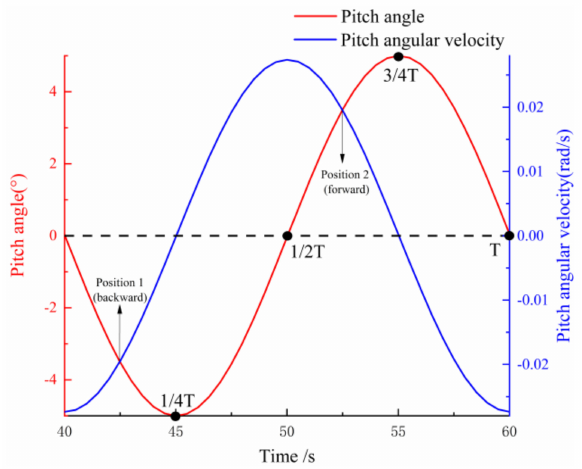
Figure 15. The two typical positions during pitch